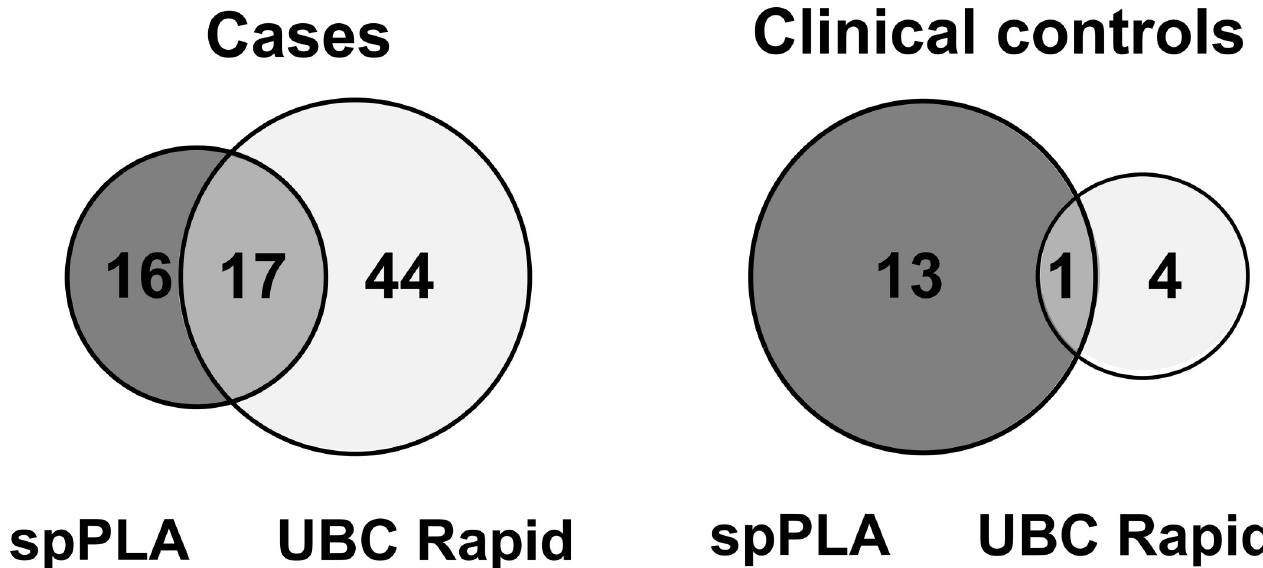
Fig 4. Venn diagram for survivin spPLA and UBC Rapid for both groups, cases and clinical controls. The cutoff for the spPLA was 1.45 pg/mL, resulting in 33 positive cases and 14 positive clinical controls. The cutoff for UBC Rapid assay was set to 10 mg/L, resulting in 61 positive cases and 5 positive clinical